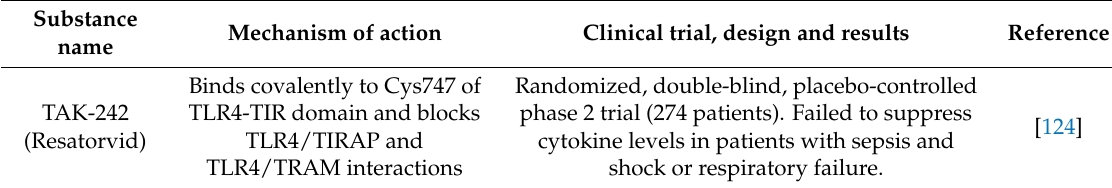
Table 1. Results of the phase II and III clinical trials for TLR4-antagonists.